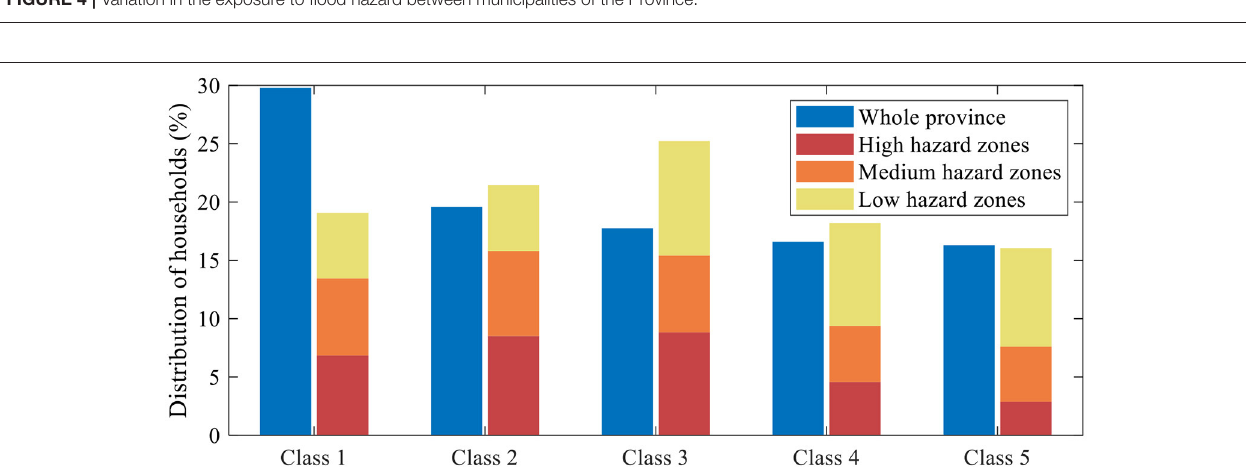
FIGURE 5 | Distribution of households as a function of their ISD class, in the whole province of Liège as well as in flood hazard zones.